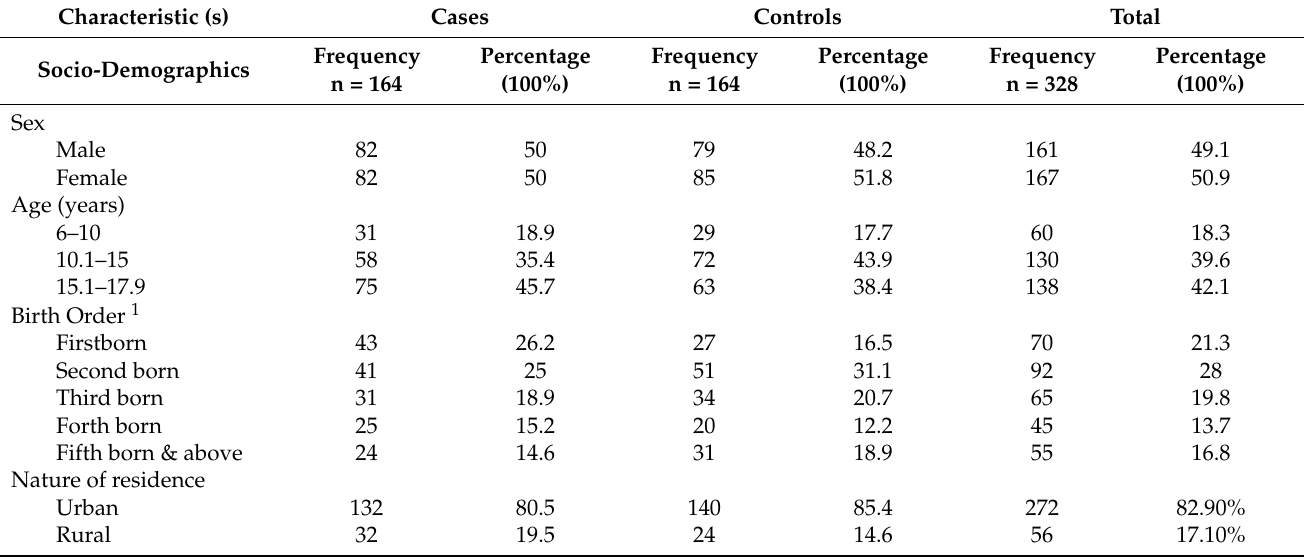
Table 1. The socio-demographic characteristics of